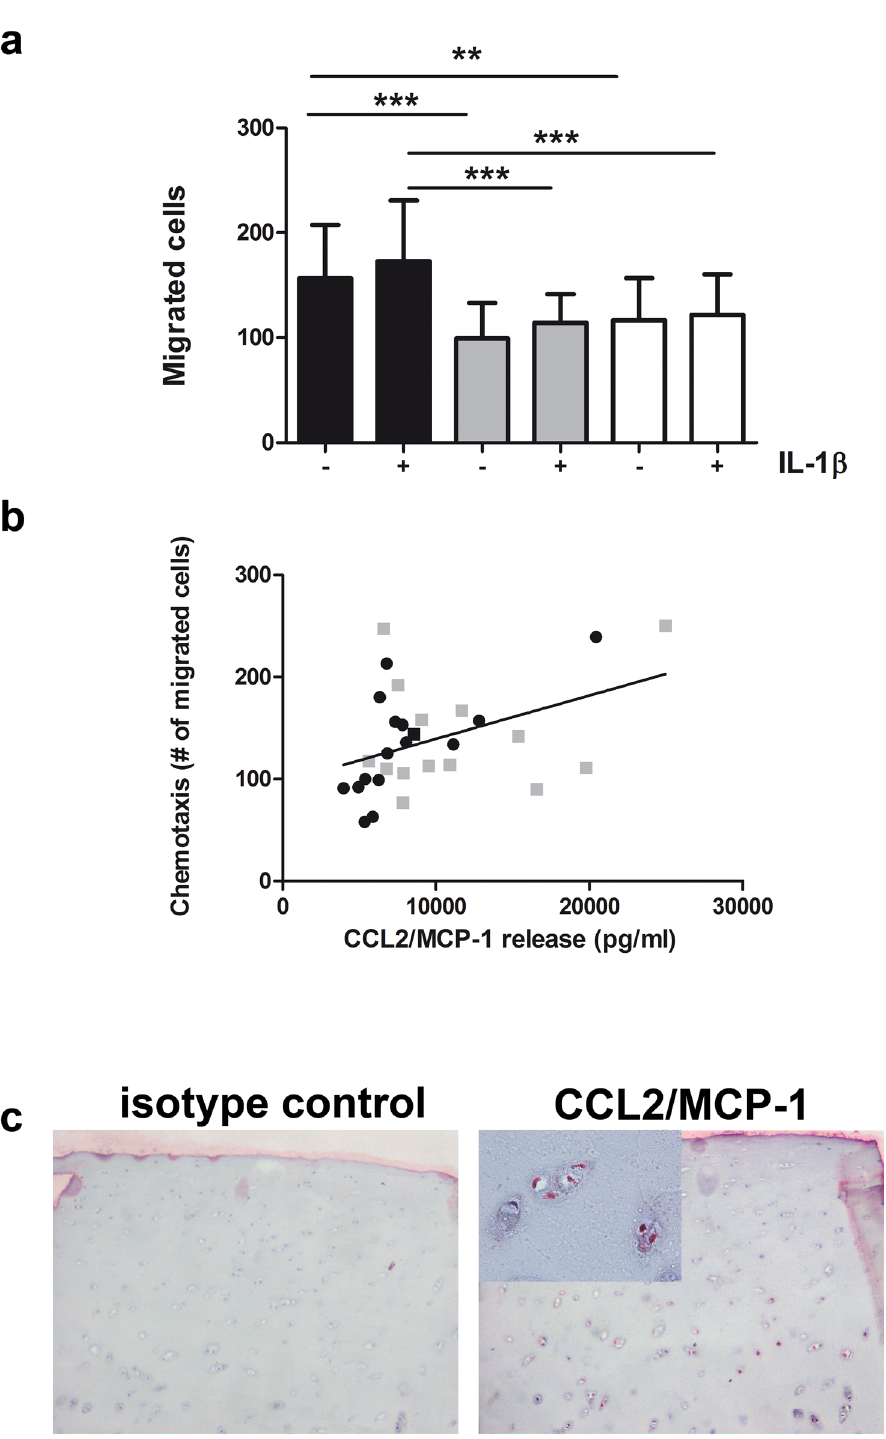
Figure 3. IKK dependency of monocyte recruitment following exposure to chondrocyte conditioned media. ( a ) Supernatants obtained from high density cultures (n = 7) of GL2 (black pattern), IKKαKD (gray pattern) or IKKβKD (white pattern) chondrocytes in control condition (−) or after IL-1β stimulation (24 h, +) were collected and assessed for the level of monocyte chemotaxis in Boyden Chambers. Data are reported as mean ± SD. The means of the groups were compared by ANOVA, followed by Tukey’s post hoc test. The differences were considered significant when p < 0.05 with *p < 0.05; **p < 0.01; and ***p < 0.001. ( b ) The extent of chemotaxis in term of number of migrated cells is highly correlated to CCL2/MCP-1 concentration (pg/ ml), as evaluated by mean of the Pearson r (r = 0.428, p = 0.02, two-tailed, n = 30). Different symbols refers to basal (full black circles) or IL-1β stimulated samples (full gray boxes). ( c ) MCP-1 is expressed in osteoarthritic cartilage as assessed by immunohistochemistry (on the left isotype control; on the right cartilage section probed with anti-MCP-1 antibody, ×4 magnification and ×40